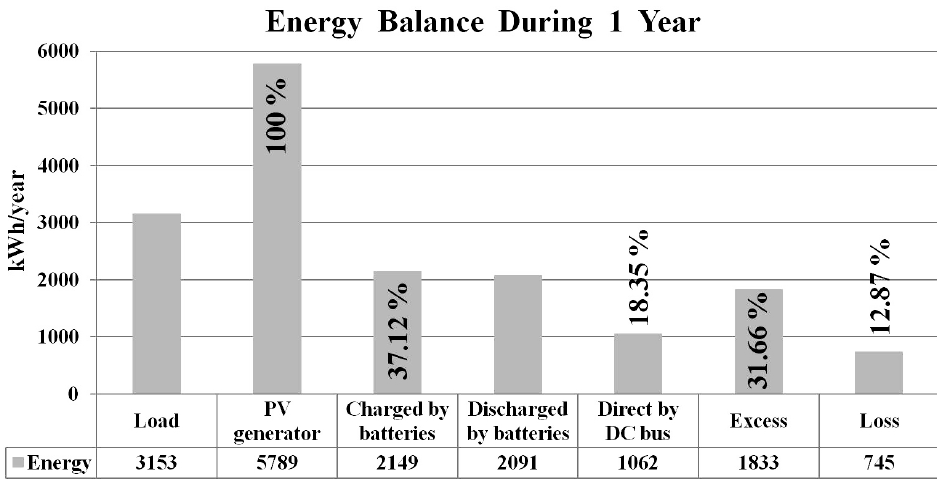
Figure 5. Energy balance for one year of operation of an EV charging station.